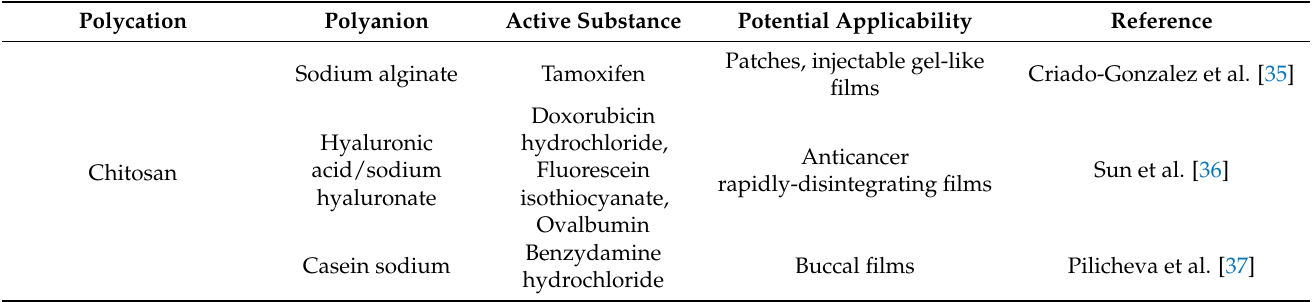
Table 2. The utility of PEMs as drug delivery systems with regard to the polycation and polyanion used, model drugs, and potential